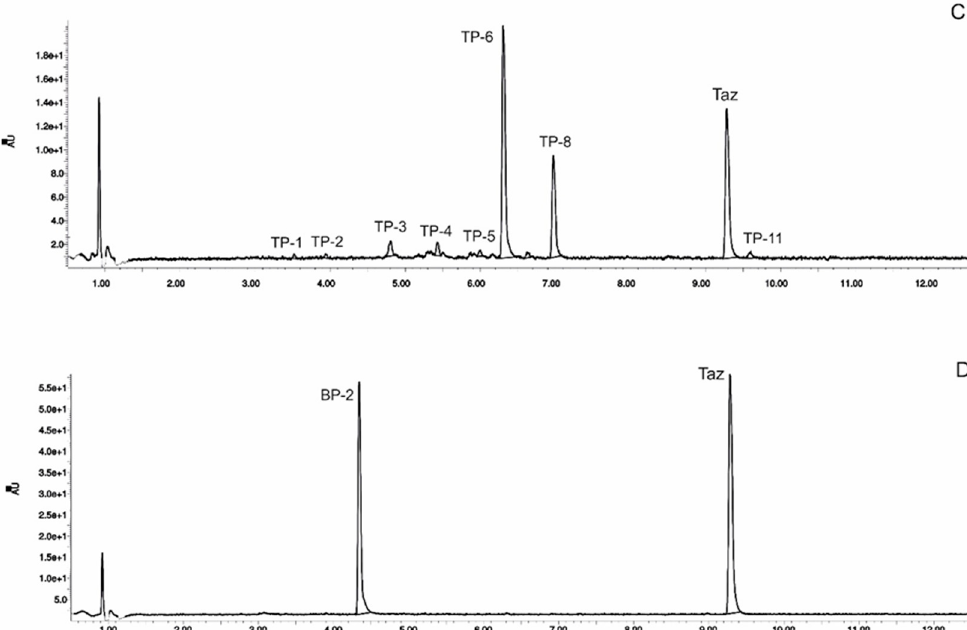
Figure 1. High-performance liquid chromatography chromatograms of tazarotene (TAZ) following UV irradiation in the presence of selected UV absorbers: ( A ) tazarotene standard, ( B ) tazarotene with sulisobenzone (BP-4), ( C ) tazarotene with TiO 2 and ZnO (TP- degradation products of tazarotene), ( D ) tazarotene with benzophenone-2 (BP-2).